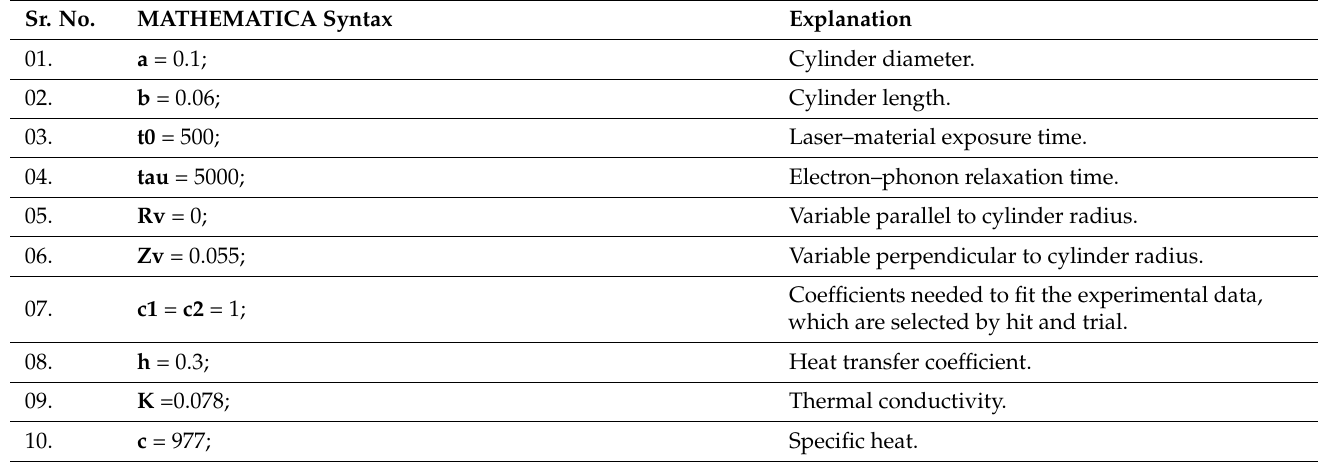
Table A3. Non-Fourier heat equation “MATHEMATICA” software user-defined codes with an explanation. Sr.